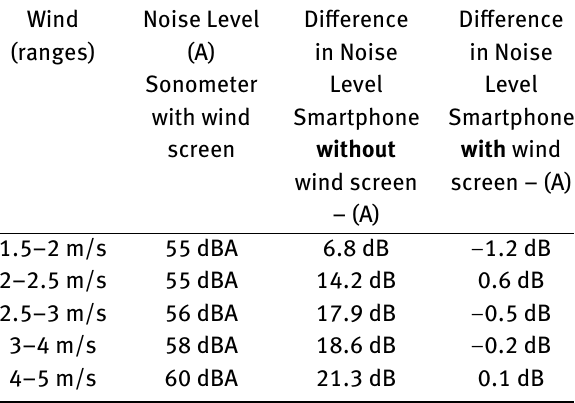
Table 2: Results of the quality of acoustic measurements in the presence of wind.